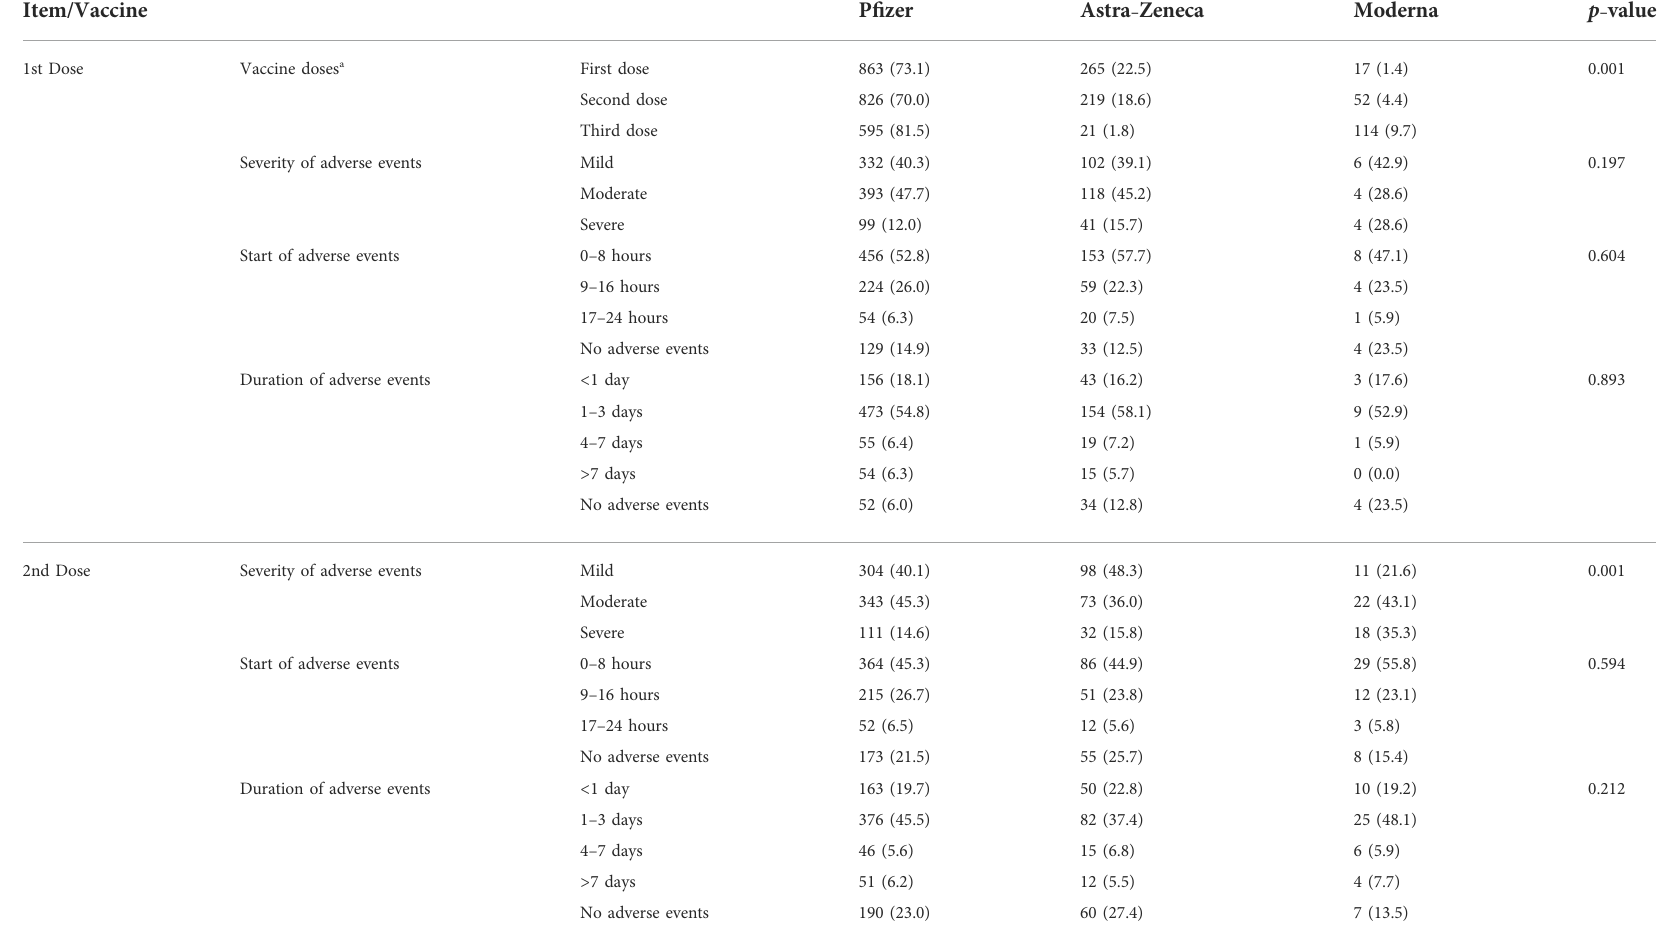
TABLE 3 Association of COVID – 19 vaccine type and the adverse events for the three doses